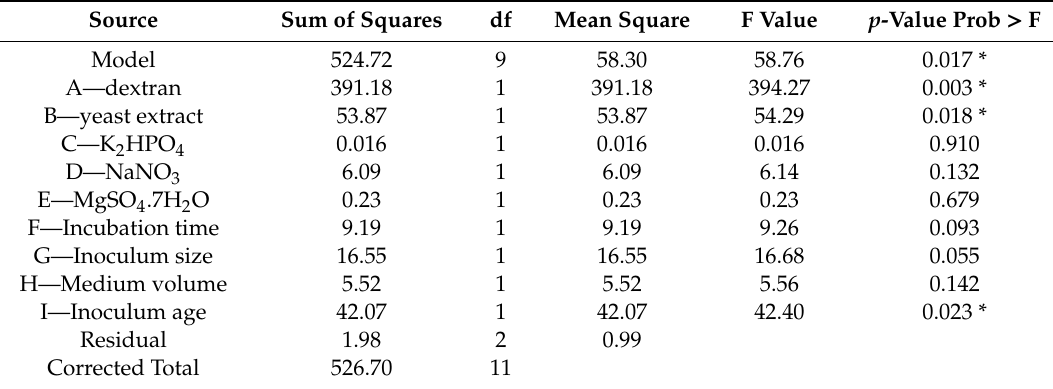
Table 2. Statistical analysis of factors a ff ecting the amount of fungal dextranase enzyme.